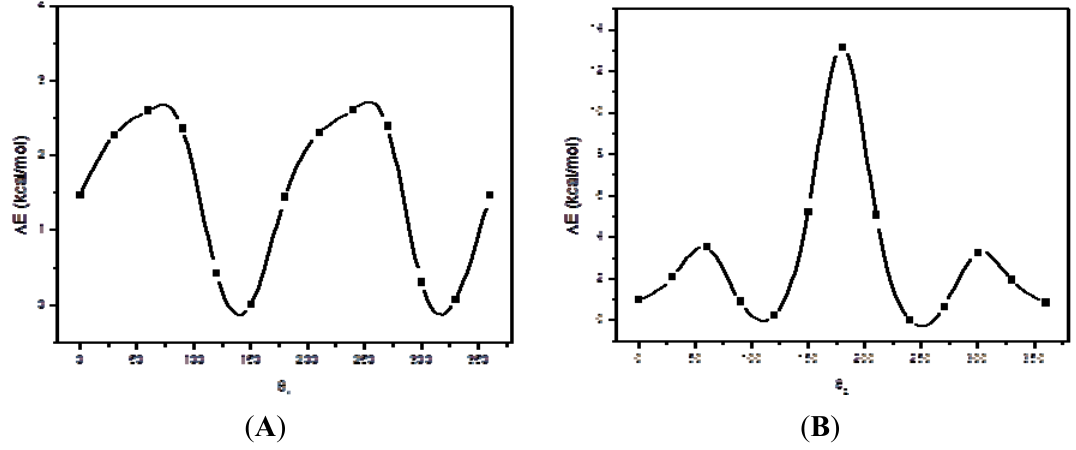
Figure 2. Potential Energy Curves (PECs) obtained for torsional the angles θ compound 5 . The curves were calculated at B3LYP/6-31G(d,p) level of